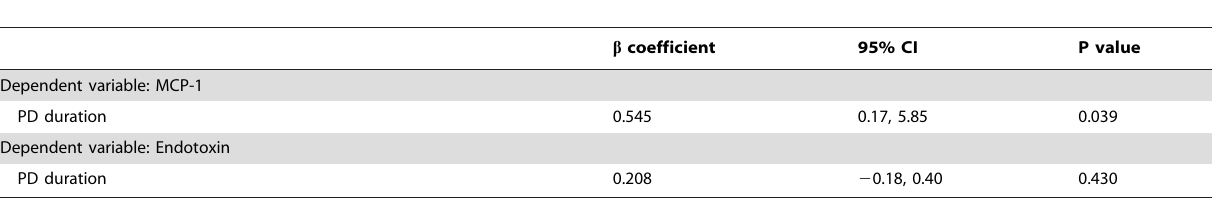
Table 4. Multivariate linear regression analyses of factors associated with circulating endotoxin and MCP-1 levels.